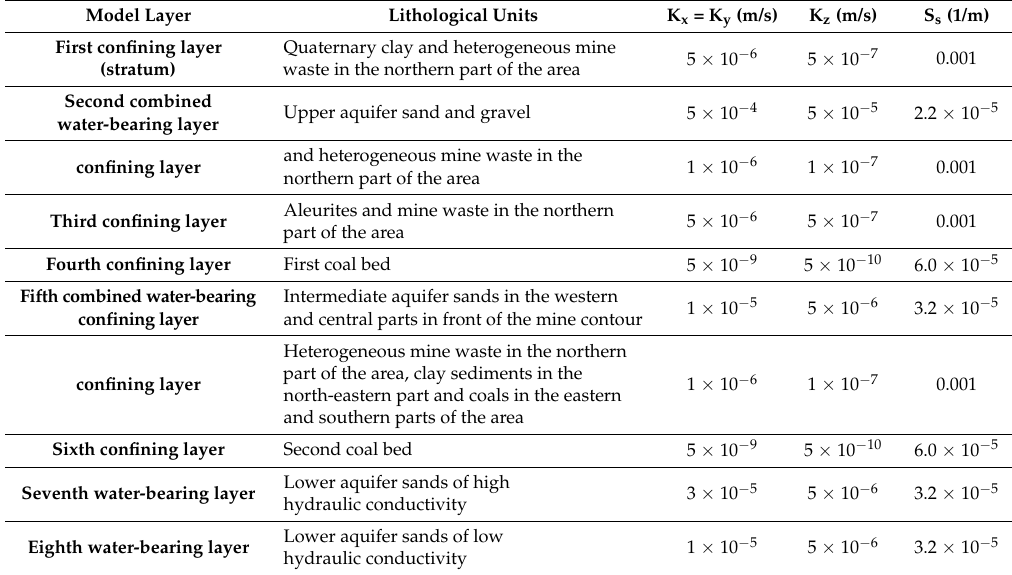
Table 1. Schematic view of the flow field—presentation of the lithological units in the model layers with initial values of hydraulic conductivity and specific